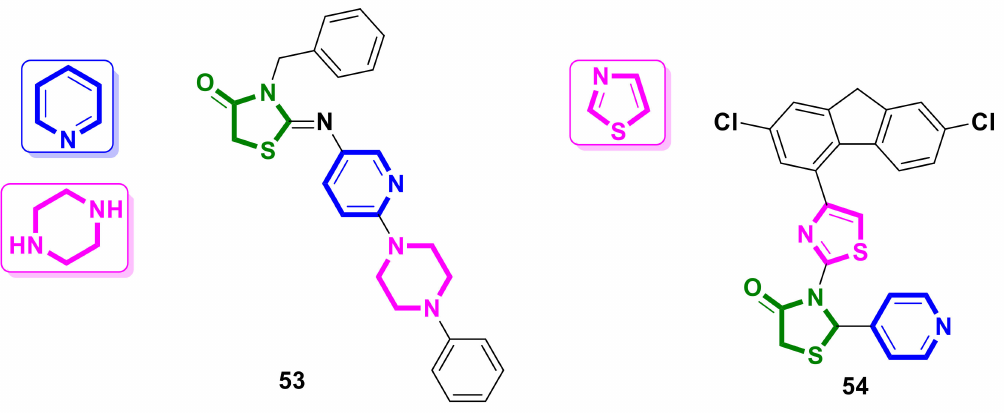
Figure 21. The structure of hybrids containing pyridine, piperazine, thiazole, and 4-thiazolidinone scaffolds in the